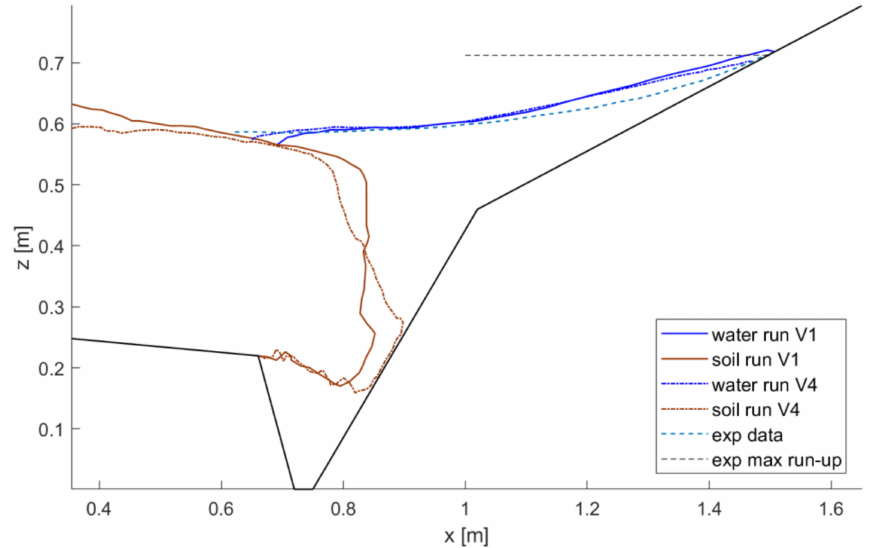
Figure 9. Comparison of maximum simulated run-up at t = 1.35 s for changes in saturation. The amount of soil penetrated into the reservoir is almost the same as in Run V1: this is confirmed by the fact that the water profiles are, on average, very close each other for both runs and hence the displaced water volume is about the same (the two extreme water volumes comprised between the water profiles of Run V1 and Run V4 balance each other). In the case of Run V4, the water surface profile is rather overlapped to the experimental one (blue dashed curve) below abscissa 1.1 m, including the left-hand front of the water surface that is closer to the experimental profile above the back of the